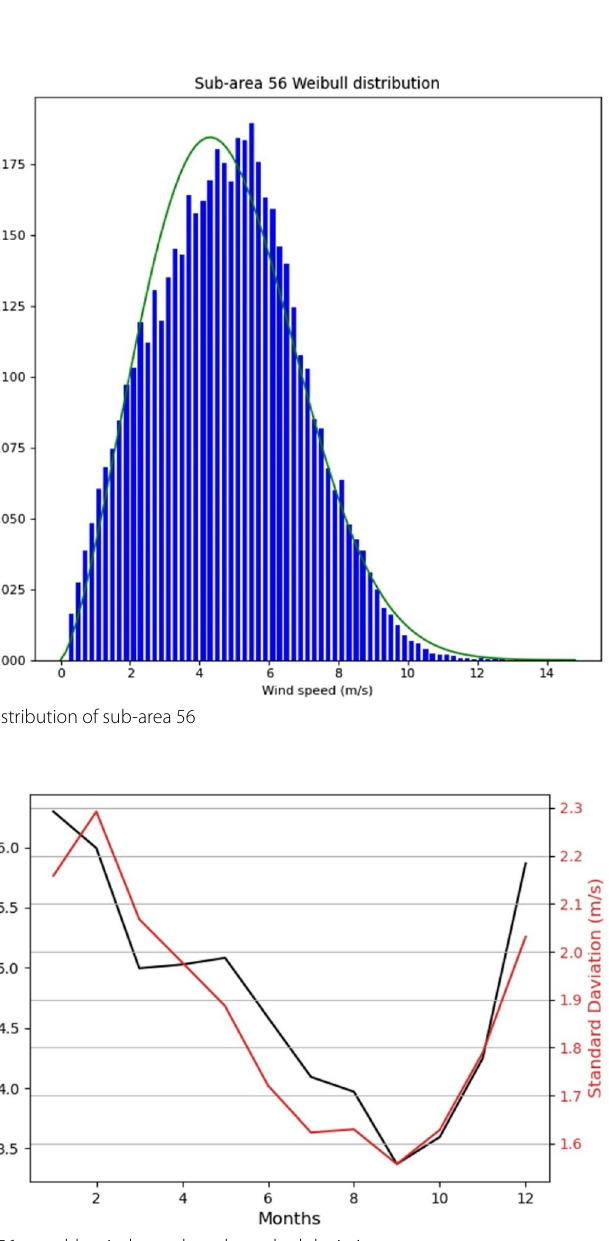
Fig. 18 Sub-area 56 monthly wind speeds and standard